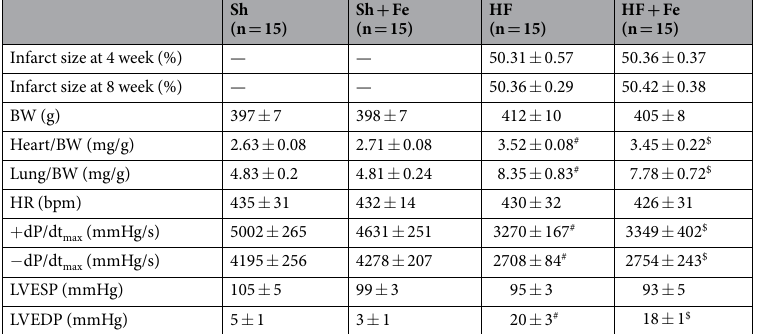
Table 1. The effect of iron supplementation on the morphometric and hemodynamic parameters in failing (HF) and control rats (Sh). Sh, sham operation; HF, heart failure; Fe, ferric carboxymaltose; BW, body weight; HR, heart rate; + dP/dt max , peak rate of left ventricular pressure increase; − dP/dt max , peak rate of left ventricular pressure decay; LVESP, left ventricular end-systolic pressure; LVEDP, left ventricular end-diastolic pressure. Data is represented as mean ± SEM; # p < 0.05 vs. Sham, $ p < 0.05 vs . Sham + Fe.